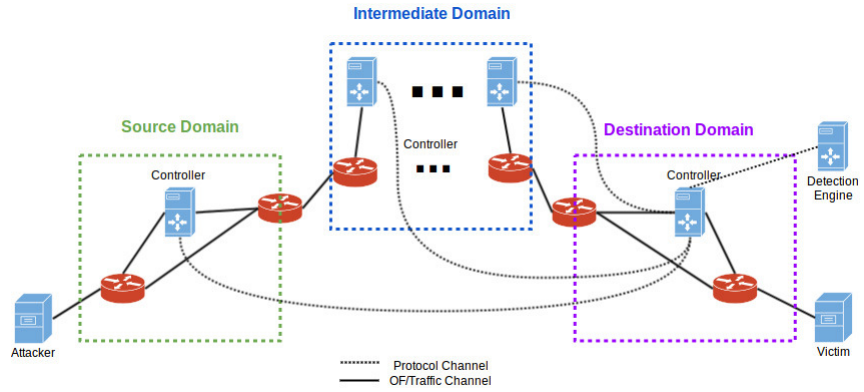
Figure 6. Mesh Connectivity for Direct Policy